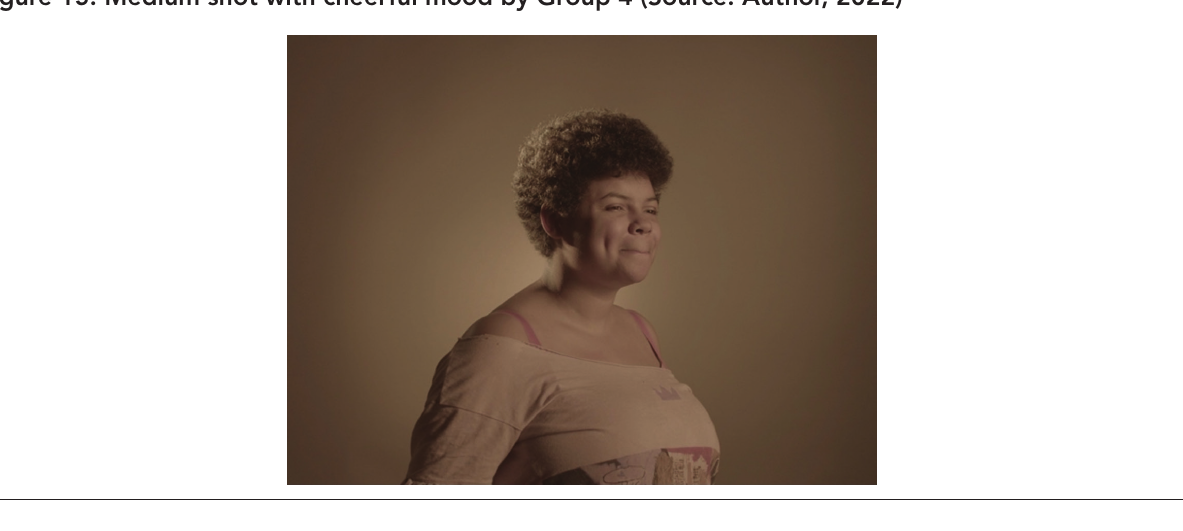
Figure 15. Medium shot with cheerful mood by Group 4 (Source: Author, 2022)